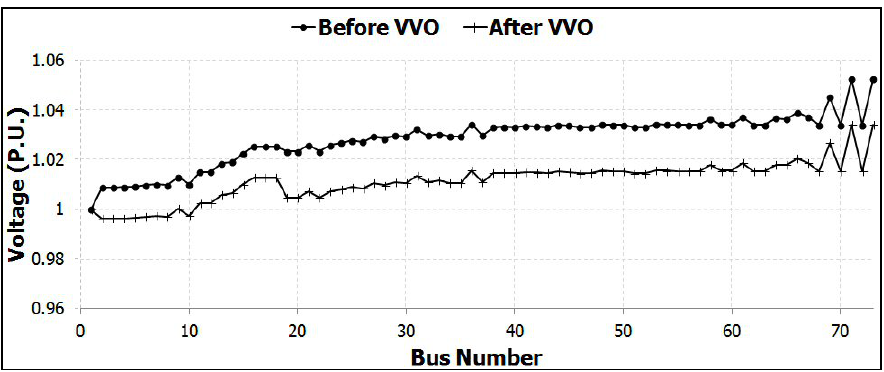
Figure 10. Voltage profile comparison for Case 2.